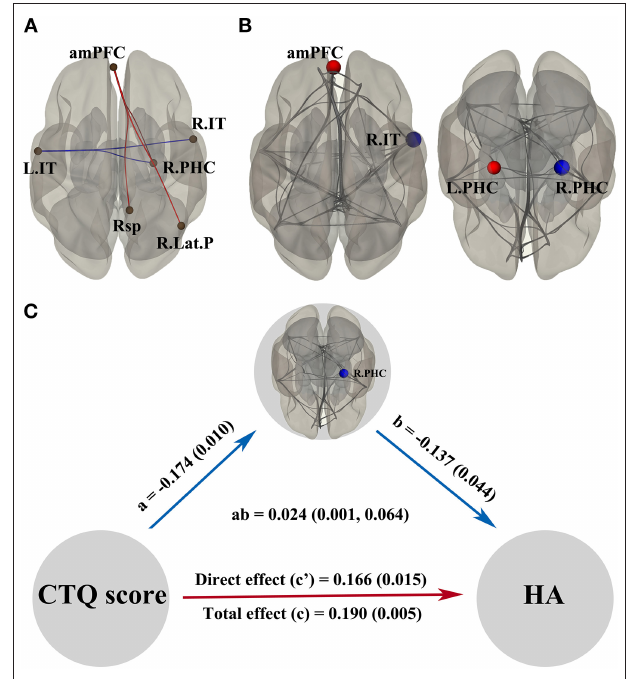
FIGURE 2 | Static functional properties of DMN related to the CTQ score and significant mediation effects in the environment-brain-behavior pathway. In (A,B) , the red line/dot represents positive correlations with the CTQ score, while the blue line/dot represents negative correlations. The betweenness centrality in R.PHC was found as a significant mediator between the CTQ score and HA score (C) . Significant indirect effects were labeled with path coefficients and 95% confidence intervals, while the direct and total effects were labeled with path coefficients and p -values. There were significant positive effects from the CTQ score to HA score, a negative effect from the CTQ score to betweenness centrality in R.PHC, and a negative effect from the betweenness centrality in R.PHC to HA score. amPFC, anterior medial prefrontal cortex; CTQ, Childhood Trauma Questionnaire; DMN, default mode network; HA, harm avoidance; L.IT, left inferior temporal cortex; L.PHC, left parahippocampal gyrus. R.IT, right inferior temporal cortex; R.Lat.P, right lateral parietal cortex; R.PHC, right parahippocampal gyrus; Rsp, retrosplenial